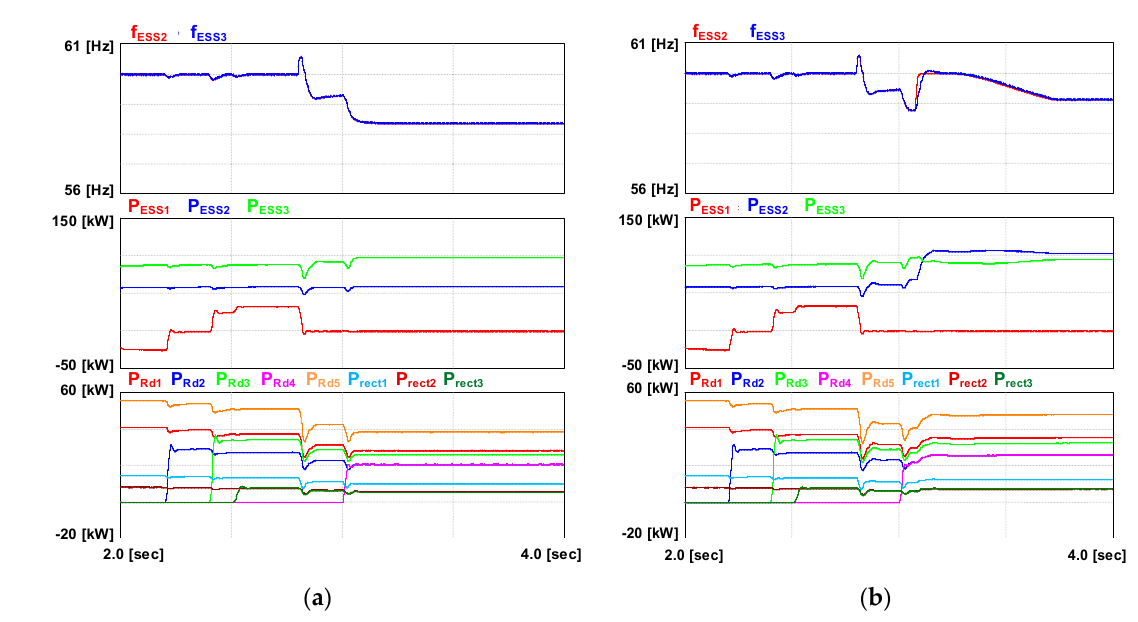
Figure 10. Simulation results (case 1 and case 2)—( a ) case 1; ( b ) case 2.